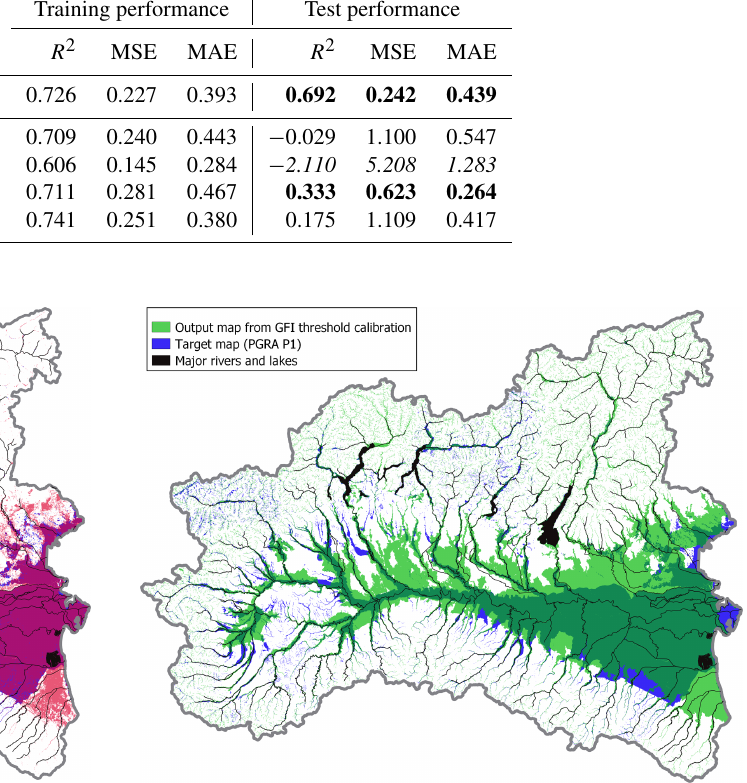
Figure 7. Multivariate 500-year flood susceptibility map for the study area (red), target flood hazard map (PGRA P1; blue). Purple indicates overlaying areas.